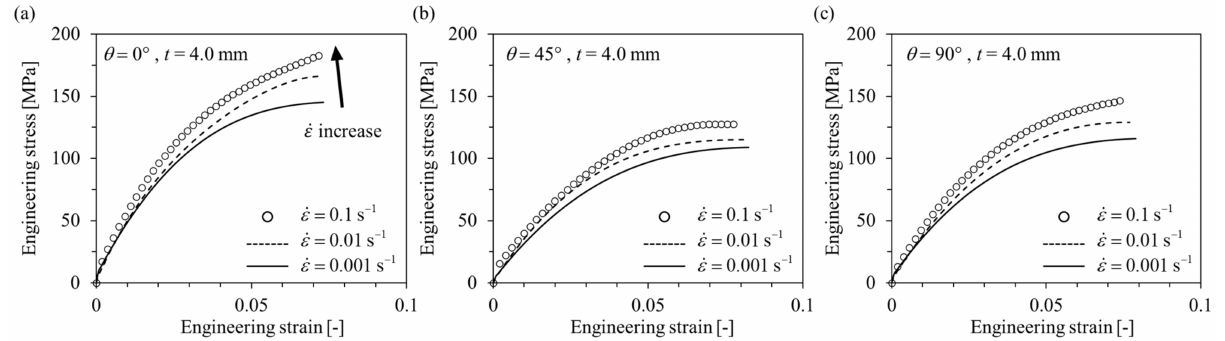
Figure 8. Compressive engineering stress–engineering strain curves of t = 4.0 mm specimens with different strain rates. ( a ) θ = 0 ◦ , ( b ) θ = 45 ◦ , ( c ) θ = 90 ◦